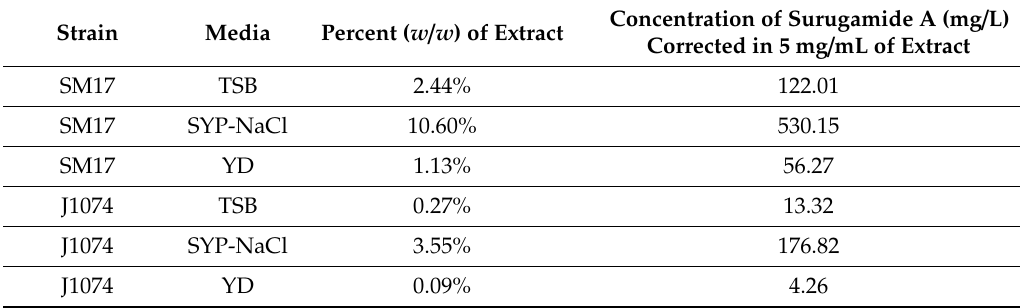
Concentration of Surugamide A (mg / L) Corrected in 5 mg / mL of Extract